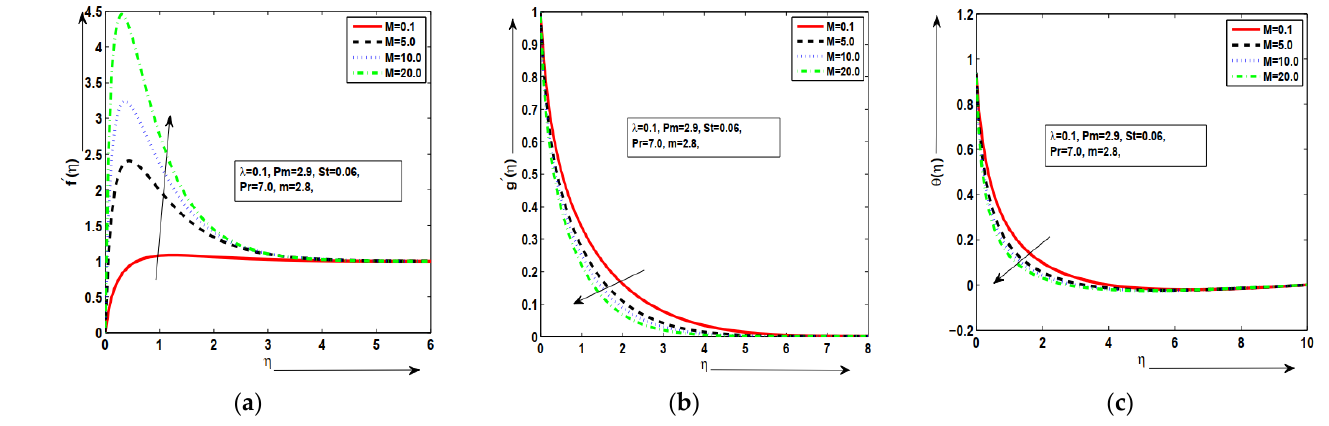
′ , and against . Figure 7. ( a – c ) The geometric profiles of Figure 7. ( a – c ) The geometric profiles of f (cid:48) ( η ) , g (cid:48) ( η ) , and θ ( η ) against M . ′ ( 𝜂𝜂 ), 𝑔𝑔 𝑓𝑓 ( 𝜂𝜂 ) 𝜃𝜃 ( 𝜂𝜂 ) 𝑀𝑀 From Table 1, it is concluded that the skin friction f (cid:48)(cid:48) ( 0 ) increased at m = 0.5 but the minimum skin friction wasobtained at small m = 0.0 in the presence of buoyancy forces. It should be noted that m = 0 corresponds to the case of a small temperature difference 0.0 between the surface and fluid, i.e., the buoyancy approximation becomes valid for this particular case, whereas for a high temperature difference, a considerable enhancement in the numerical values of the skin friction and heat transfer rate wasinspected and can be clearly seen in Table 1. It wasdeduced that the magnetic intensity − g (cid:48)(cid:48) ( 0 ) wasmaximum at larger m = 0.5 but the smaller quantity of magnetic intensity wasexamined at smaller m = 0.0 in the presence of strong magnetic field. This result was expected because an increase in M means enhancement in the Lorentz forces which opposes the flow and velocity of the fluid decreases. It was also expected because as magnetic Prandtl number increases, the viscosity of fluid increases and fluid becomes thicker and consequently the boundary layer thickness decreases. It is also depicted that the heat transfer wasincreased at maximum m = 0.5 but the lower quantity of heat transfer is depicted at minimum m = 0.0 in the presence of magnetic force M . With the increase in value of M , the magnetic field became stronger along the surface which is a clear indication that the Lorentz force is more effective in this case. In Table 2, the influence of stratification St number with various values along a vertical plate is shown to check the behavior of physical properties of the rate of skin friction, the rate of magnetic intensity, and the rate of heat transfer. From Table 2, it is computed that the skin friction is maximum at smaller value of St = 0.1 but the minimum quantity of skin friction is depicted at a large value of St = 0.4 in the presence of Prandtl number P r = 7.0. Physically, it is possible because thermal conductivity decreases as Pr increases, which has a lower magnitude of frictional forces between the viscous layers. It is depicted that the magnetic intensity is decreased at larger St = 0.4 but the maximum value of magnetic intensity is explored at small St = 0.1 in the presence of λ = 6.5. However, due to the strong buoyancy number λ which acts like a pressure gradient and dominated over the resistance, skin friction is increased and slight changes in heatand magnetic intensityare noted. It is also mentioned that the heat transfer − θ (cid:48) ( 0 ) wasmaximum at the lower value of St = 0.1 but the minimum quantity of heat transfer wasnoticed at larger St = 0.4 in the presence of magnetic Prandtl number P m = 8.3. The reason behind this is that increasing the value of P m is equivalent to decreasing magnetic diffusivity and consequently the strength of magnetic field becomes